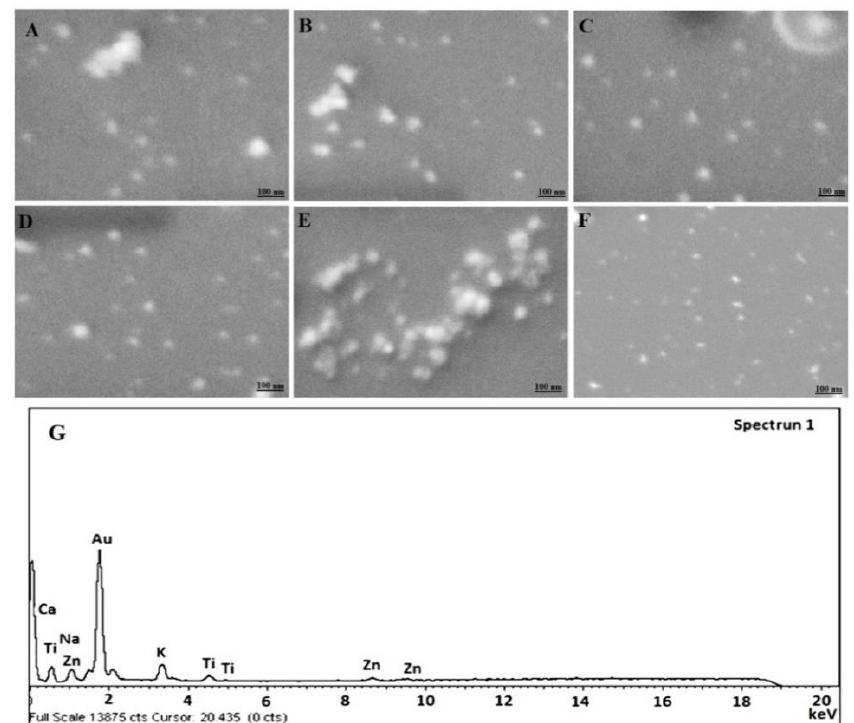
Figure 1. Scanning electron microscopy (SEM) micrograph of ( A ) F9 (Placebo GP), ( B ) F10 (Placebo CGP), ( C ) F11 (5-CGP), ( D ) F12 (5-GP), ( E ) F14 (Placebo CGP), ( F ) F15 (5-CGP) and ( G ) EDX (energy dispersive X-ray spectroscopy) image of F11. 50.35 KX magnification and scale of 100 nm.